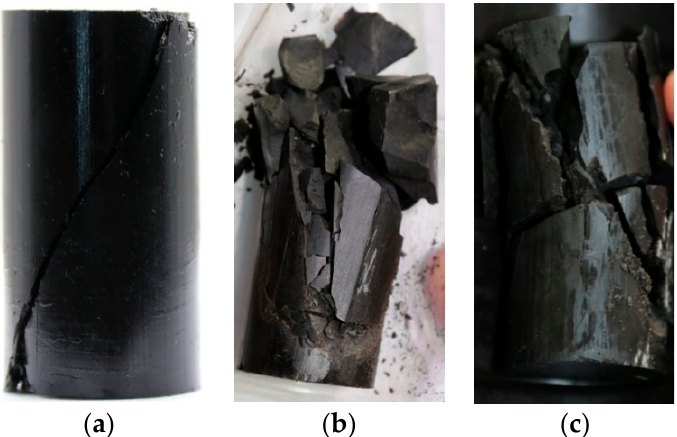
Figure 13. Damage diagram under a7 MPa confining pressure: ( a ) moisture content: 0%; ( b ) moisture content: 1.06%; and ( c ) moisture content: 1.40%.